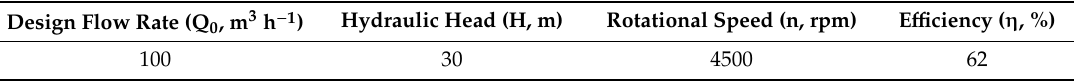
Table 2. Design parameters.